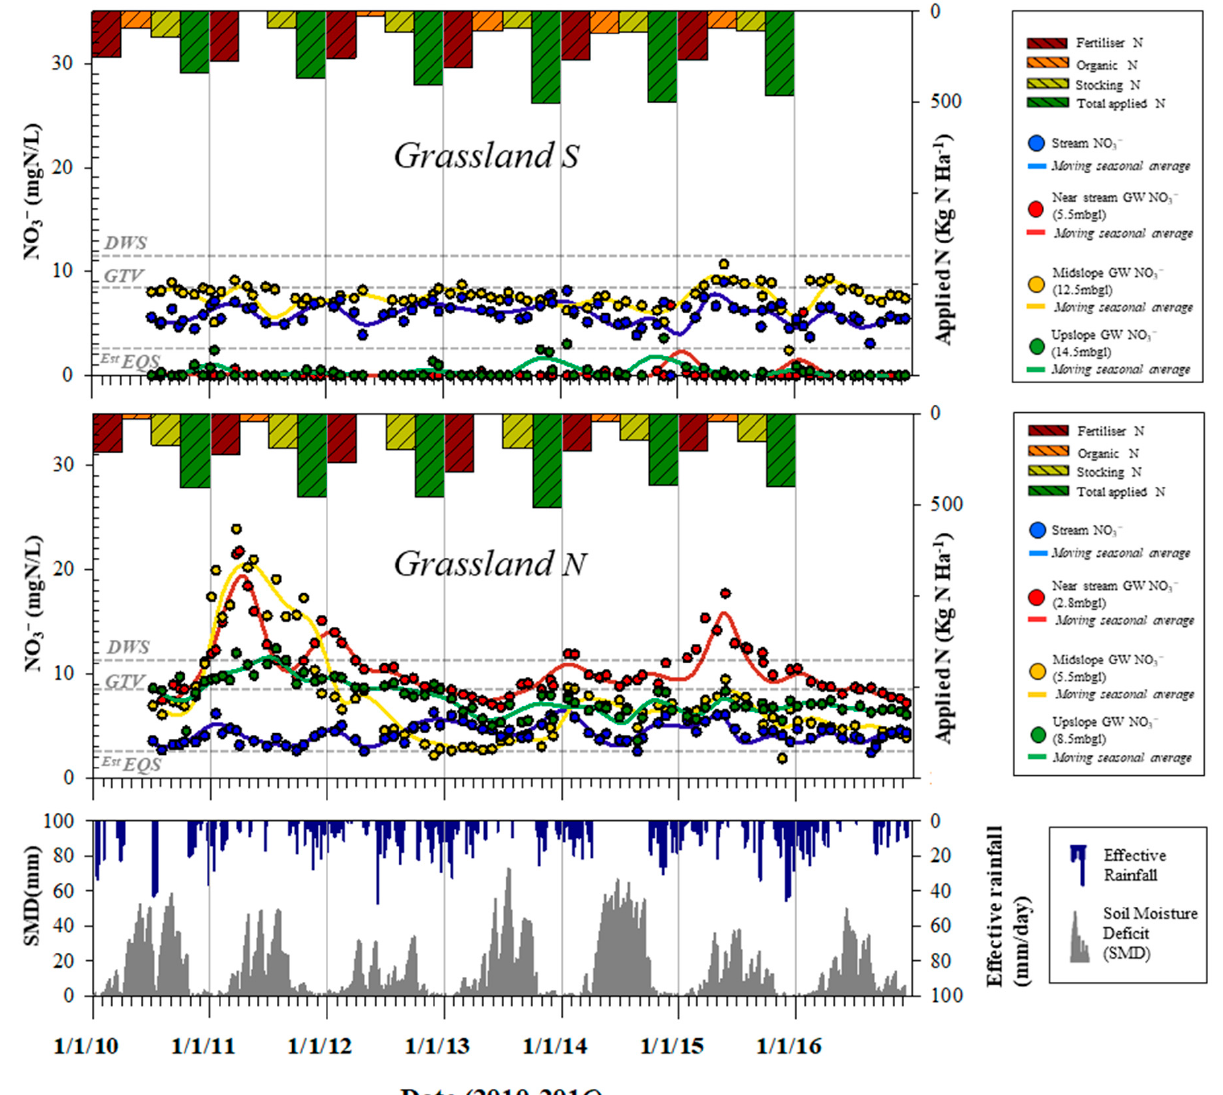
Figure 4. Grassland hillslope temporal trends in groundwater and stream NO 3 − , effective rainfall, soil moisture deficit and nitrogen application from 2010 to 2016.